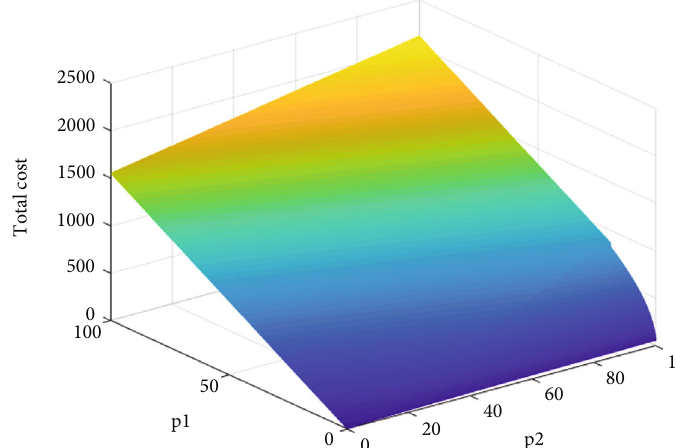
p 1 and 2 on total